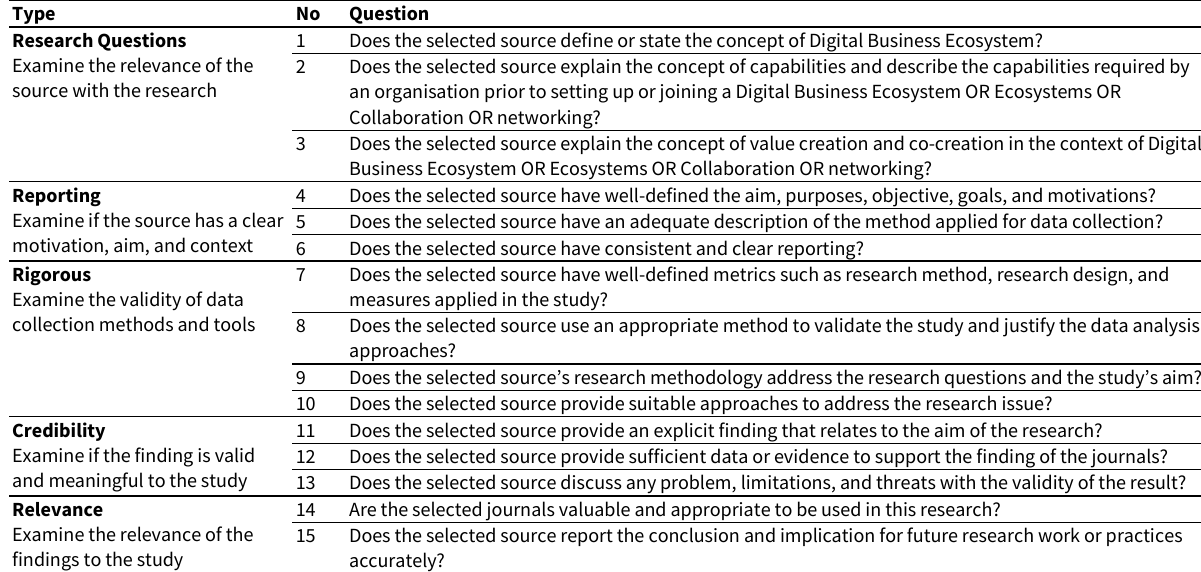
Table 3. QA checklist adapted from Zhou et al. (2015)